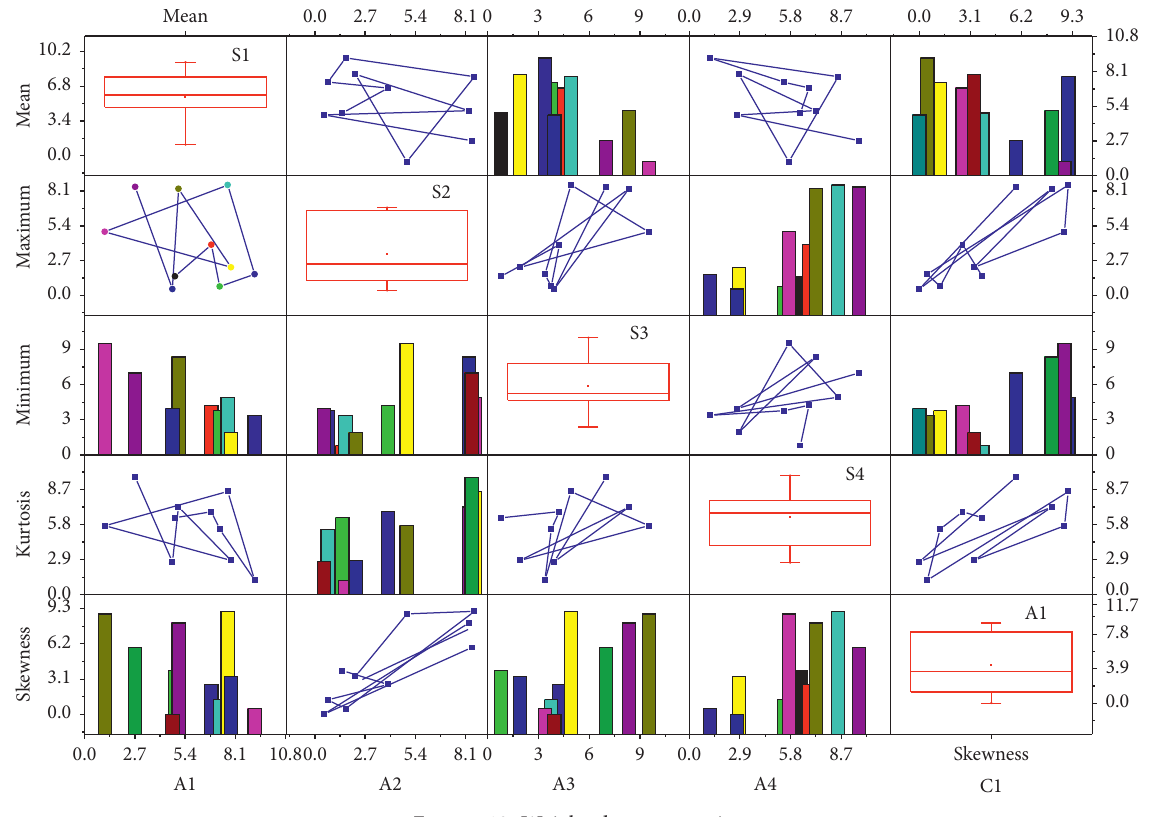
Figure 10: Weighted super